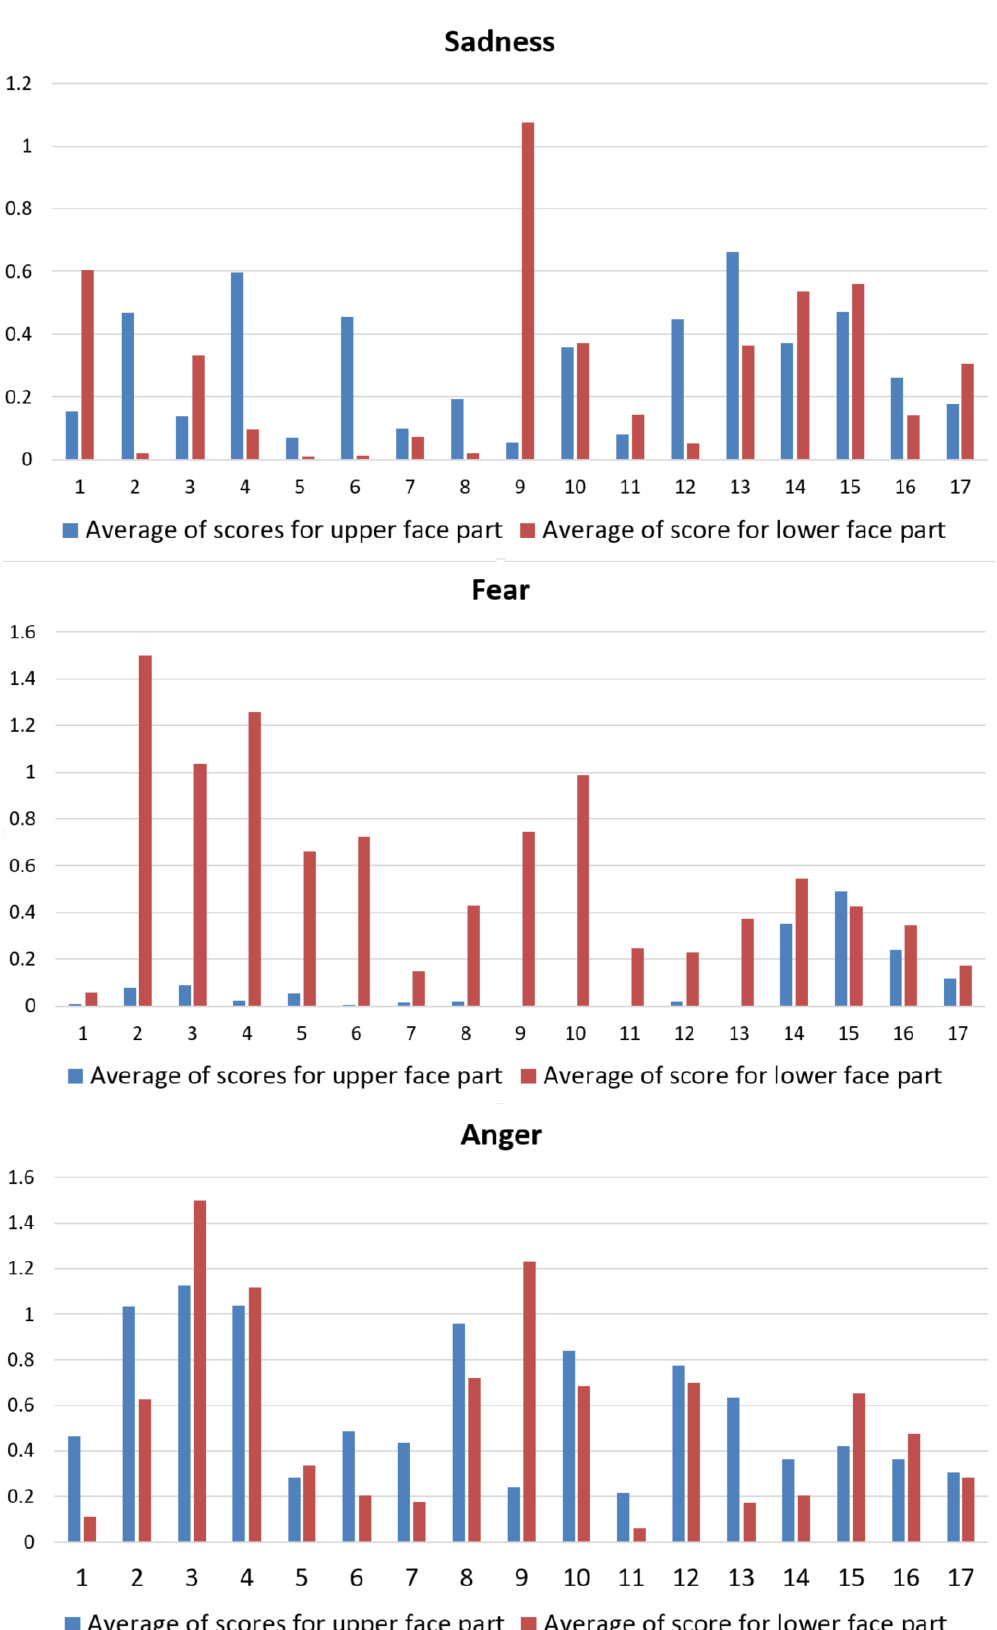
Figure 9. Graphical representations of average production scores computed for each of the 17 ASD children. From top to bottom: Happiness, Sadness, Fear and Anger related values.Blue bars are related to upper face part, whereas red bars are related to lower face